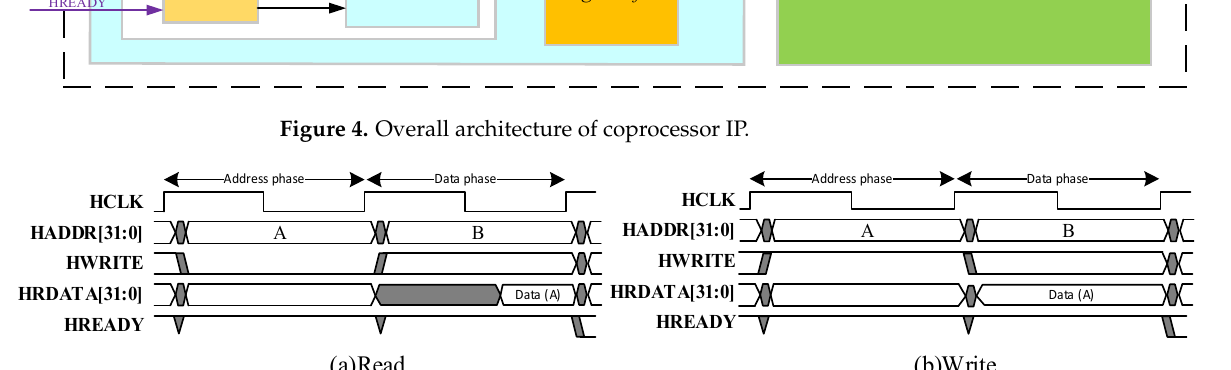
Figure 4. Overall architecture of coprocessor IP.